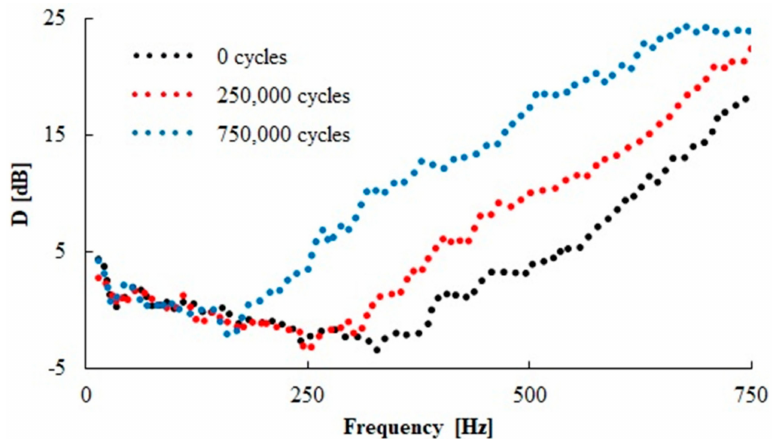
Figure 16. E ff ect of number of loading cycles on frequency dependencies of the transfer damping function (D) for the N 330 rubber composite measuring t = 20 mm in thickness, with inertial mass m = 500